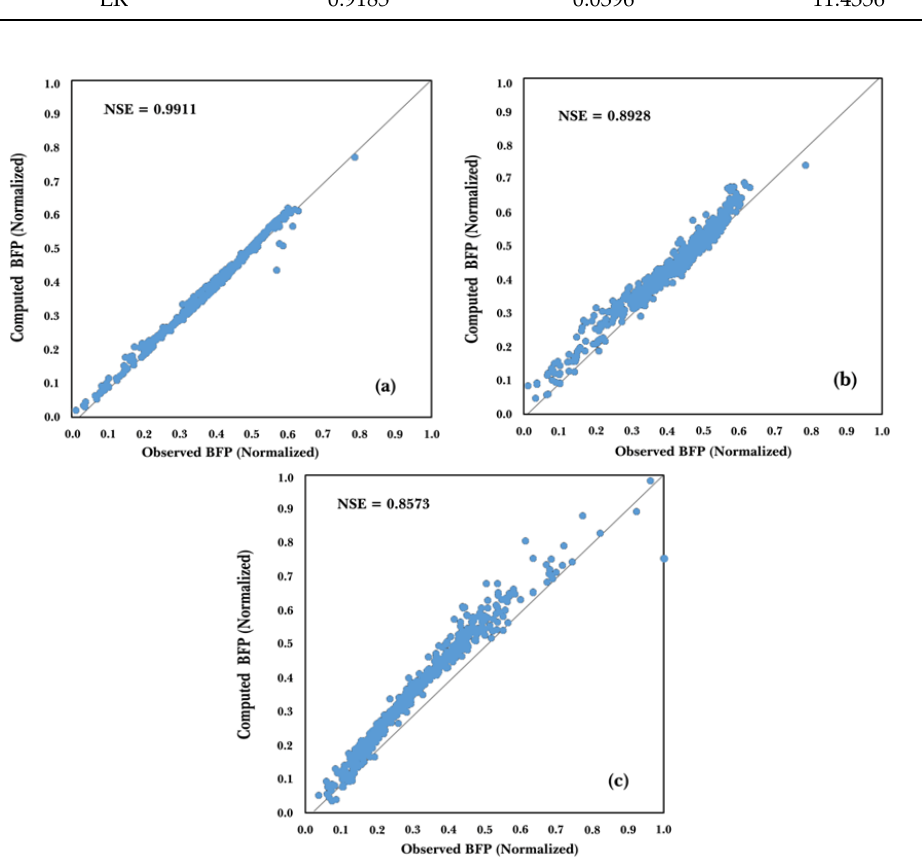
Figure 6. Scatter plots of the testing stage for predicted BFP: ( a ) SVR ‐ EANN, ( b ) EANN, ( c ) FFNN.